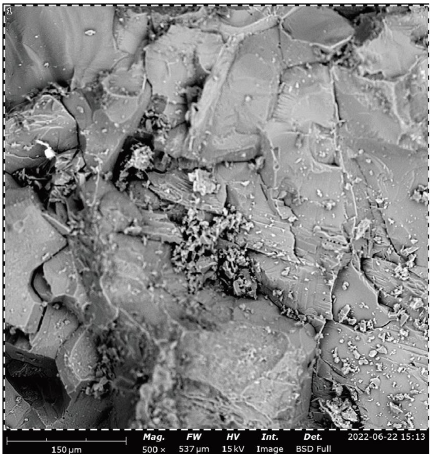
Figure 35: SEM for M3 sample.